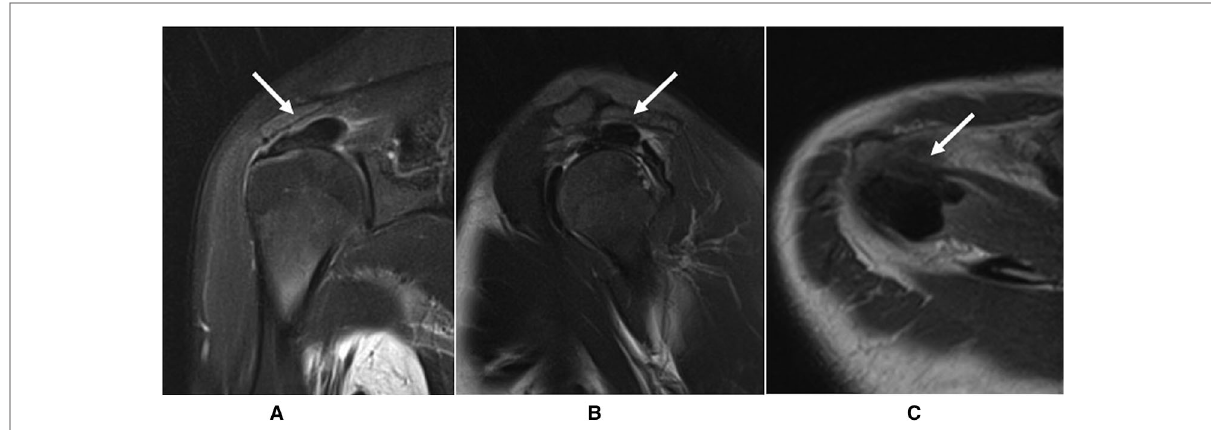
FIGURE 2 MRI showed the calci fi c deposits in the target shoulder in in the ( A ) oblique coronal; ( B ) sagittal; and ( C ) horizontal plane.